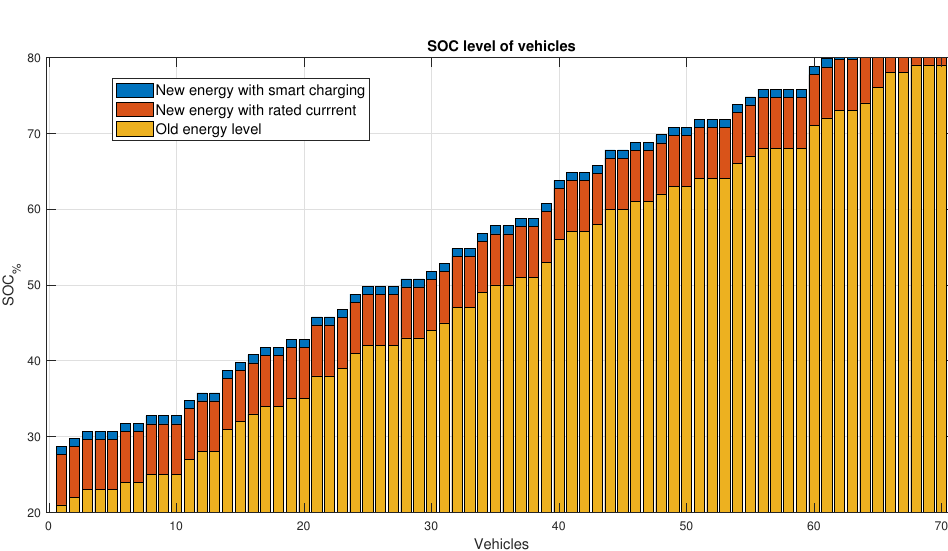
Figure 5. EBs SoC at time step t and t +